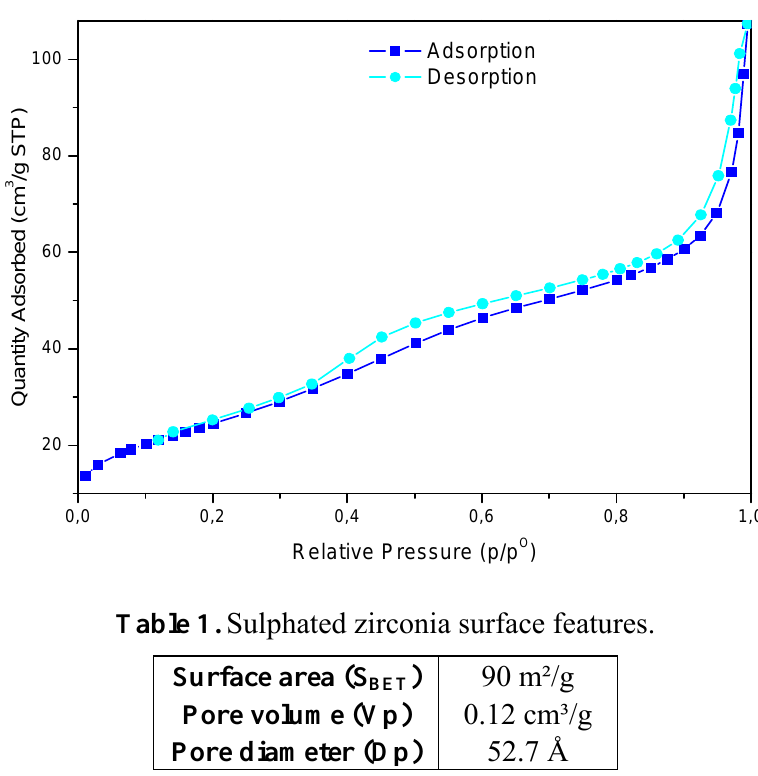
Figure 2. Nitrogen adsorption-desorption plot of sulphated zirconia.